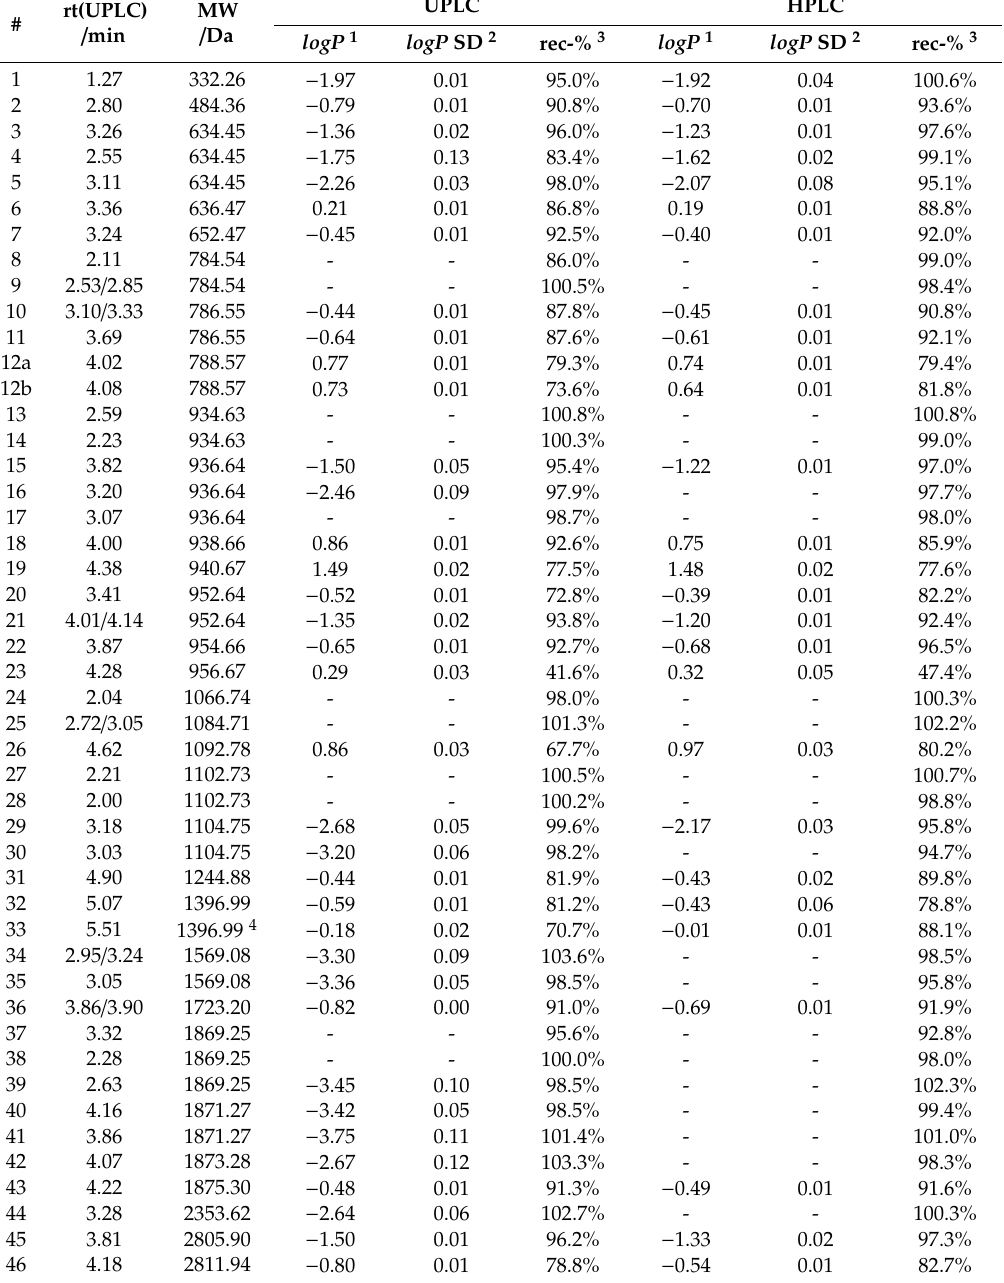
Table A1. LogP values, standard deviations (SDs) and recovery percentages (rec-%) of 47 hydrolysable tannins (Figures 1 and 2) measured with UPLC and HPLC along with their retention times in UPLC (rt) and molecular weights